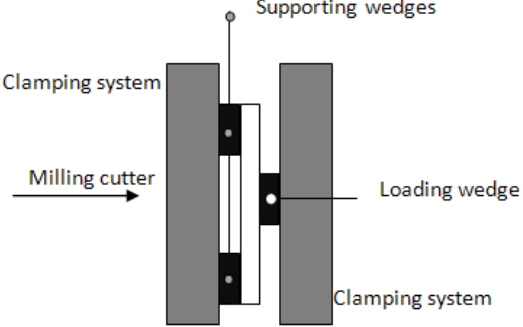
Figure 3: Top view of the three-point bending load